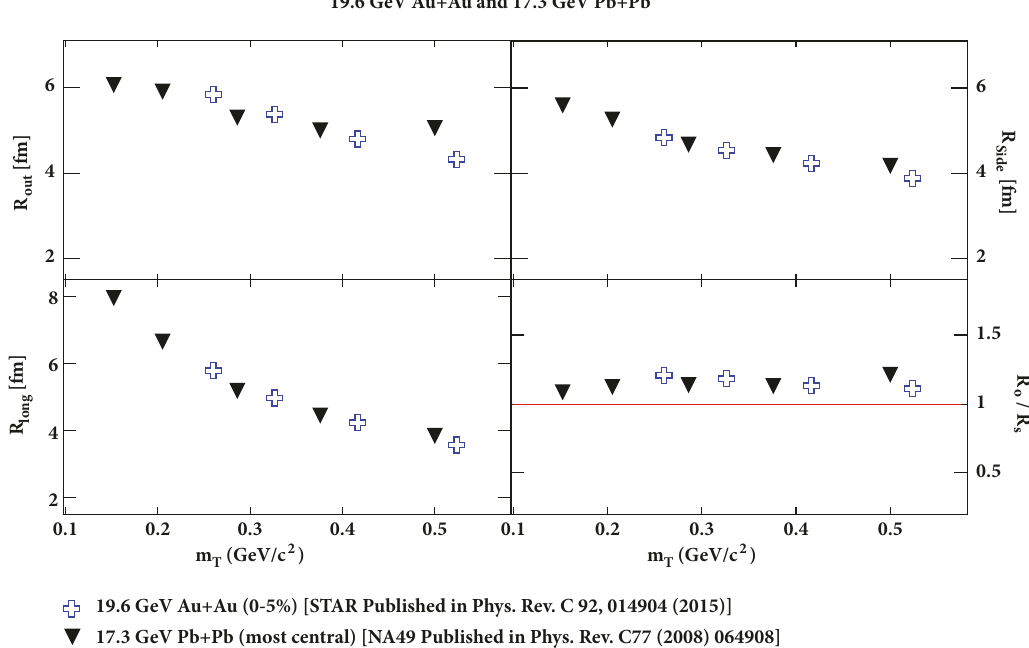
Figure 1: The comparison of system size dependence in HBT radii of STAR Au+Au collisions at √𝑠 NN = 19.6 GeV with NA49 Pb+Pb collisions for 17.3 GeV. Only statistical errors are shown for the top central data of both experiments.